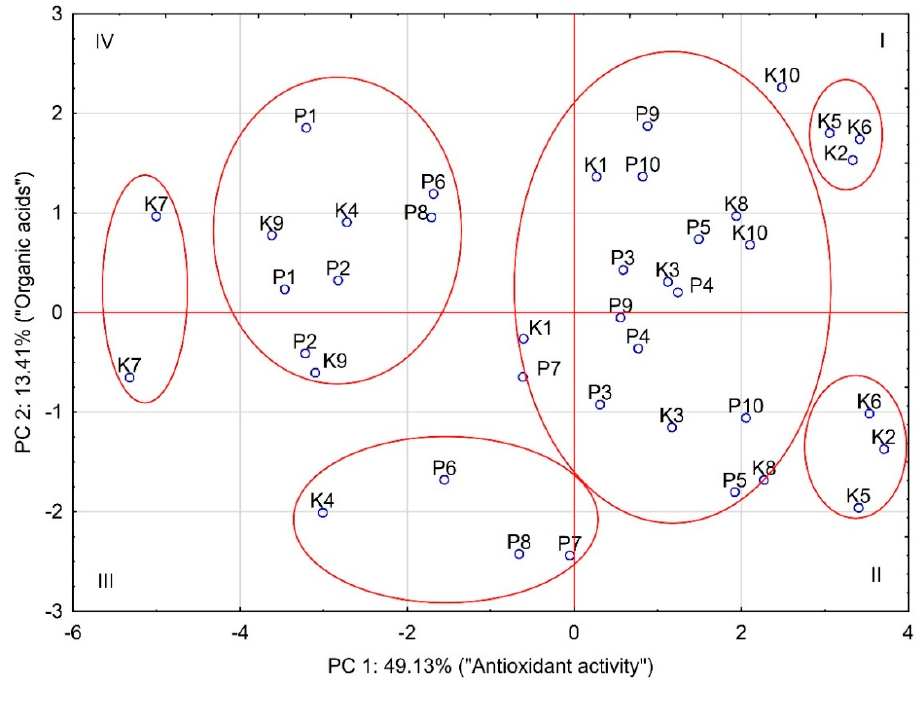
Figure 3. Biplot based on first two principal component axes for chemical composition and antioxidant activity of buckwheat sprouts ( A ) and distribution of two cultivars of buckwheat sprouts based on the first two components obtained from principal component analysis ( B ). K